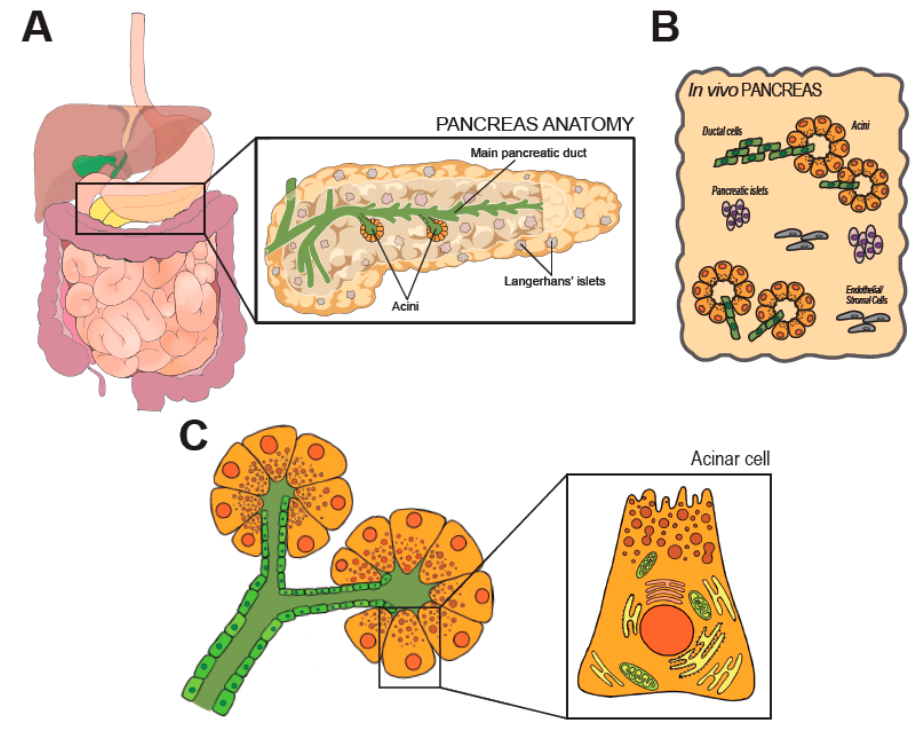
Figure 1. Anatomy and histology of the pancreas. In ( A ) anatomic organization of the GI tract. The pancreas is magnified on the right, along few representative structures within the organ. ( B ) shows the cellular heterogeneity of the pancreas, which is a composite of exocrine (acini), endocrine (Langherans’ islets) and stromal elements. ( C ) shows the modular units of the exocrine pancreas (acini). Morphology of an acinar cell is magnified on the right.